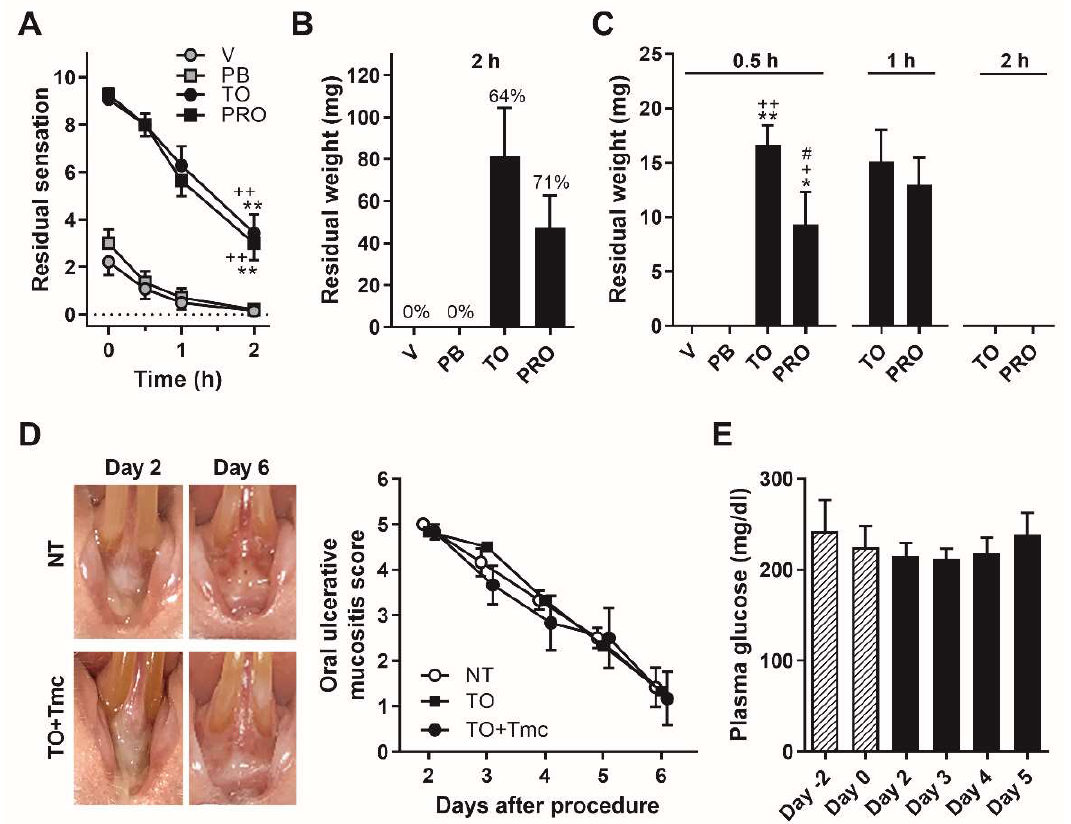
Figure 1. Residual periods of ointments on the oral mucosa of healthy humans and rats and the effects of triamcinolone acetonide (Tmc) on the oral ulcerative mucositis score and blood glucose level. V: Vaseline, PB: Plastibase, TO: Traful and PRO: Traful PRO-quick. ( A ) Residual sensation of each ointment at four different mucosal areas on the back of the upper and lower lip. The ointments were randomly applied by the participant’s fingers ( n = 14). ** and ++ , p < 0.01 for all time points, compared with V and PB, respectively, according to Tukey’s test following two-way ANOVA. ( B ) Residual weights of ointments on the oral mucosa of healthy humans 2 h after application. TO and PRO could be collected from 64% ( n = 9/14) and 71% ( n = 10/14) of the subjects. ( C ) Residual weights of ointments collected from the labial fornix region of rats (each ointment, n = 4). * and + , p < 0.05 and ** and ++ , p < 0.01 compared with V and PB, respectively, and # , p < 0.05 compared with TO according to Tukey’s test following one-way ANOVA ( f = 0.89). ( D ) Effects of TO and TO with Tmc on the oral ulcerative mucositis score (two-way ANOVA, f = 0.46, 0.74, 0.80, 0.82, 0.86 at days 2–6, respectively) in the oral ulcerative mucositis model. NT: non-treatment, TO: TO treatment without Tmc and TO + Tmc: TO treatment with Tmc; each group n = 6. ( E ) Effect of TO with Tmc on blood glucose levels in the oral ulcerative mucositis model ( n = 5, one-way ANOVA, f = 0.25).